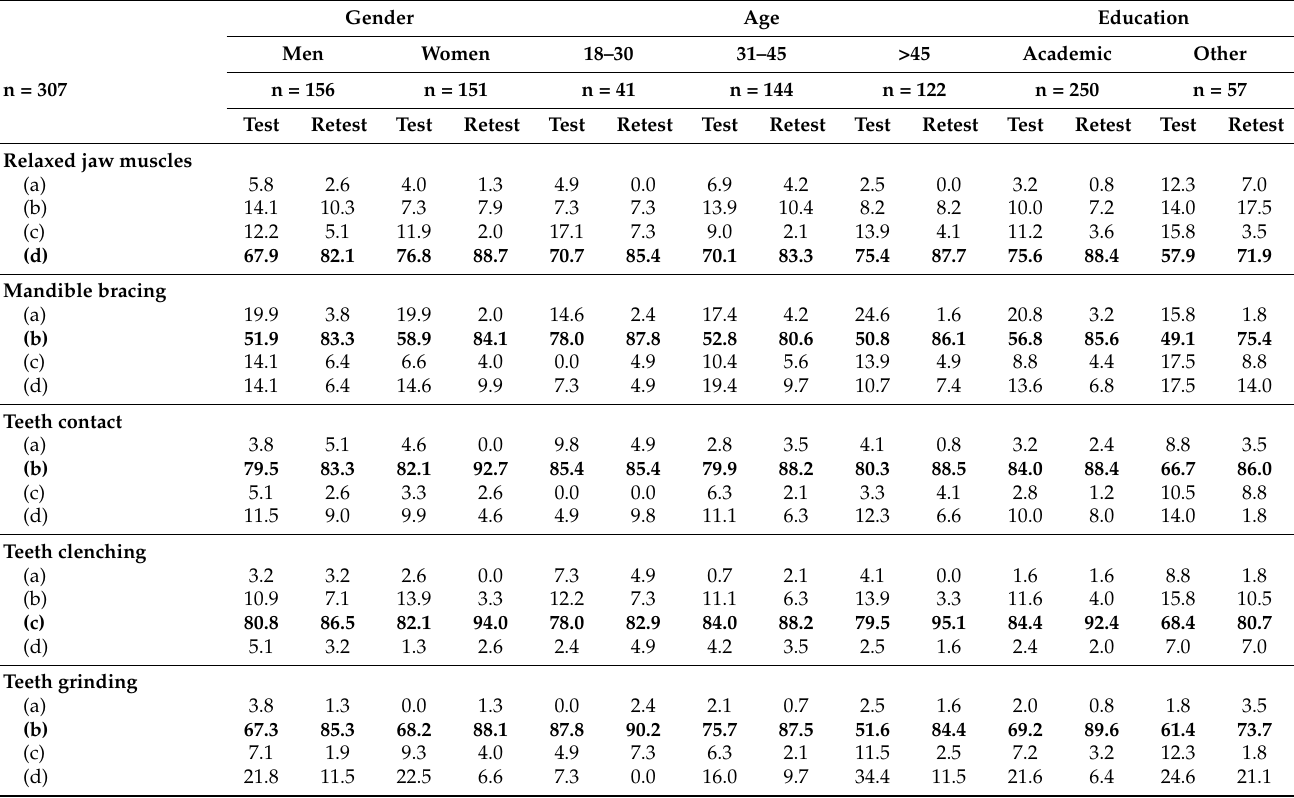
Table 2. Test-retest answers by gender, age, and level of education. Percentages.